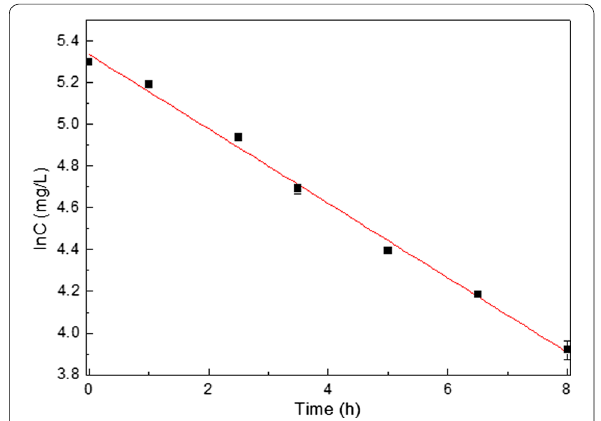
Fig. 5 Kinetic curve of degradation